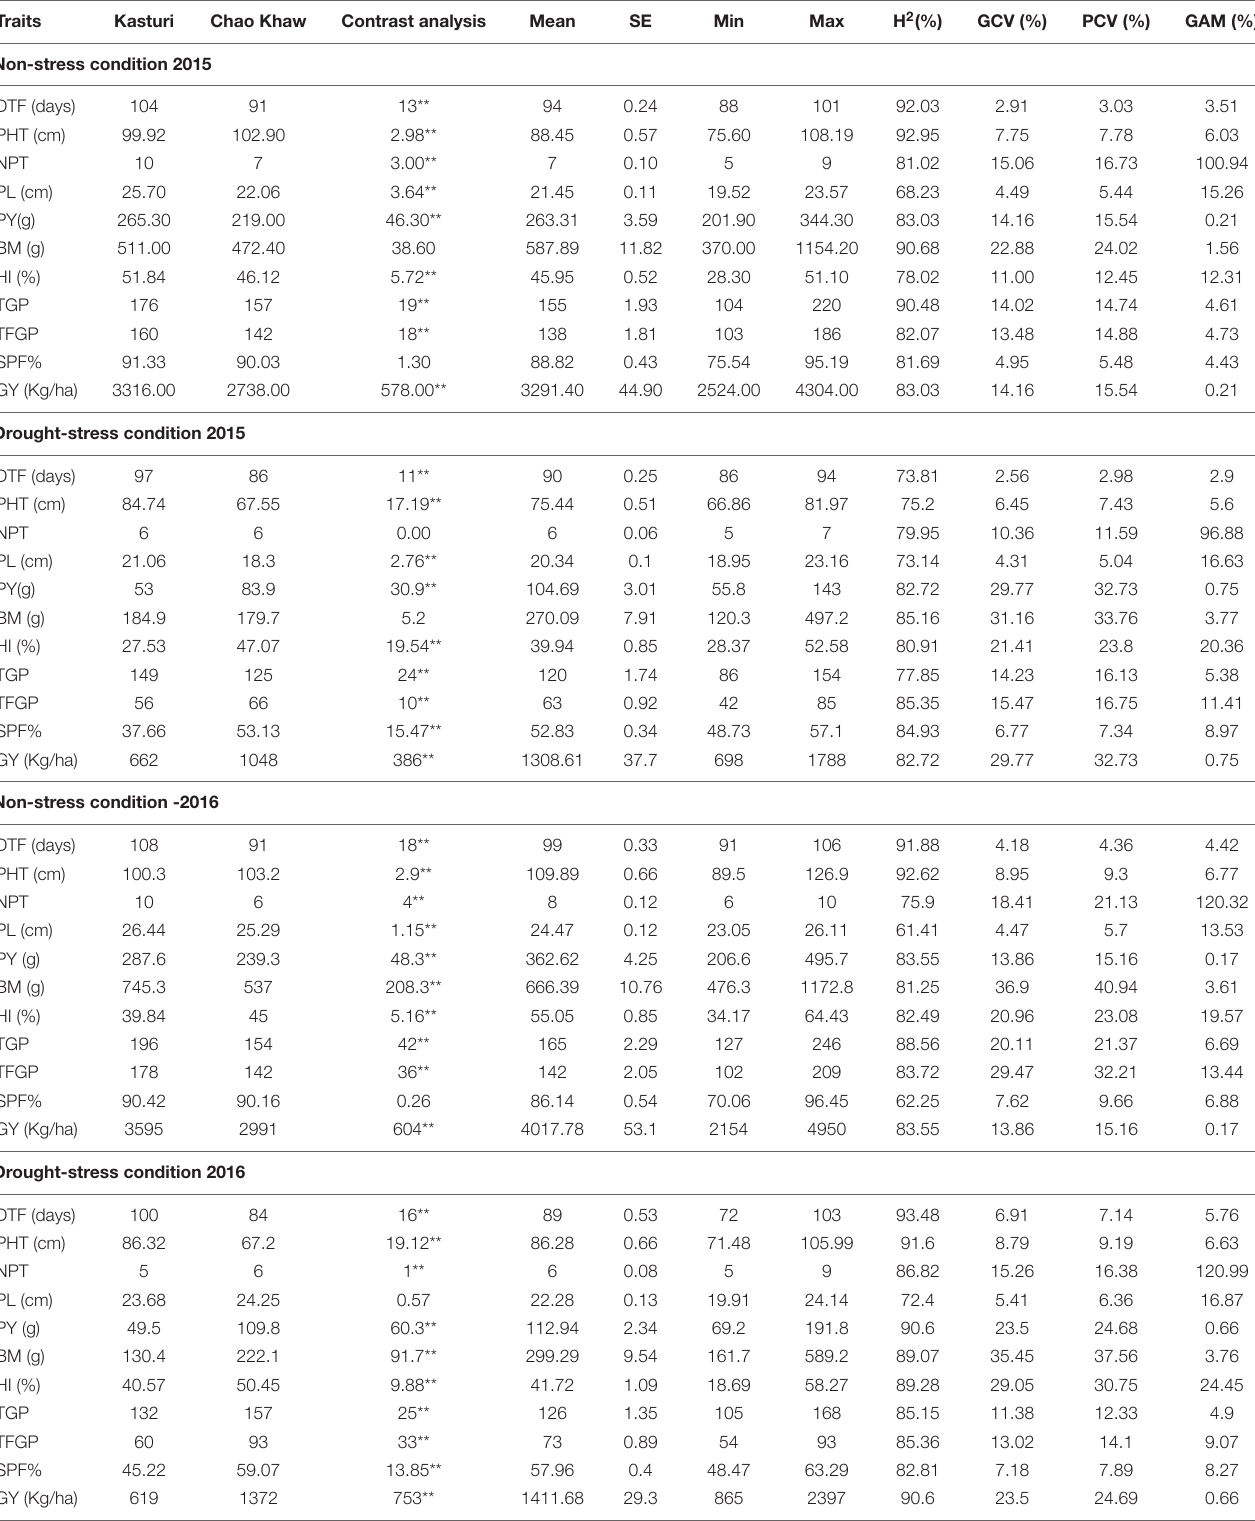
TABLE 1 | Genetic parameter estimation of various traits under non-stress and drought-stress conditions for Kasturi × Chao Khaw derived population. Traits Kasturi Chao Khaw Contrast analysis Mean SE Min